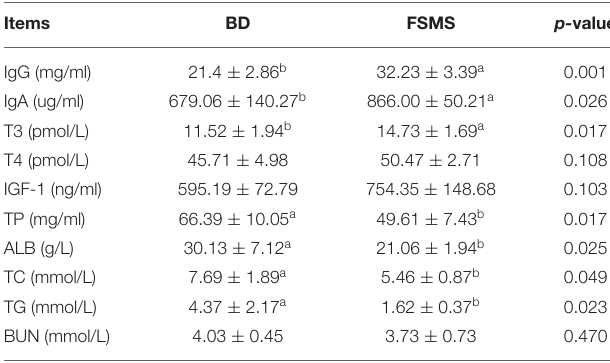
TABLE 3 | Influence of FSMS addition on porcine blood biochemical indexes.